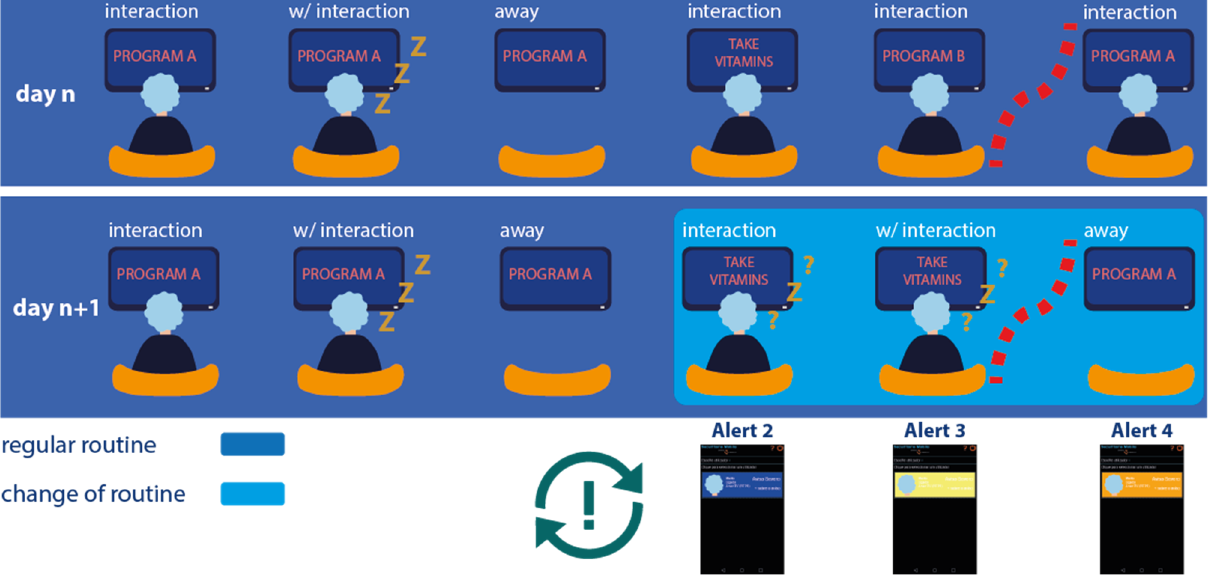
Figure 19. An example of a deviation in an elderly person’s domestic activity. In the second line (day n + 1) of Figure 19, the daily routine is changed, and the algorithm detects a deviation from the elderly person’s usual activity, and alerts are sent to response from the